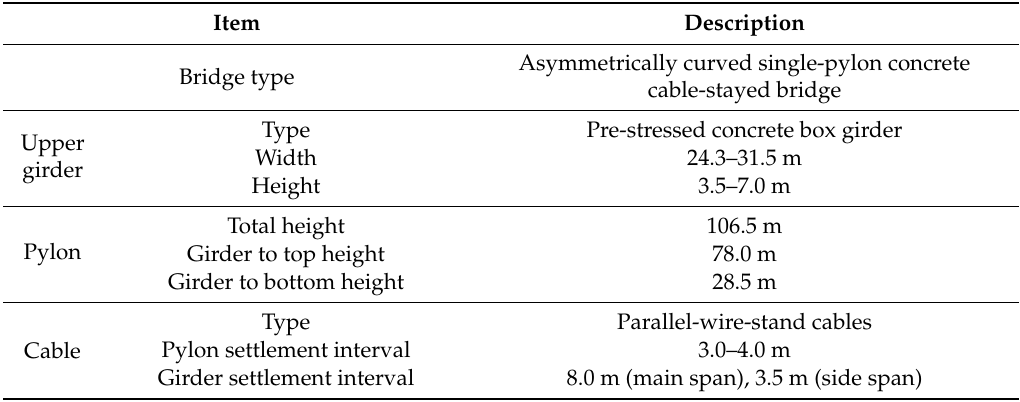
Table 1. Testing bridge